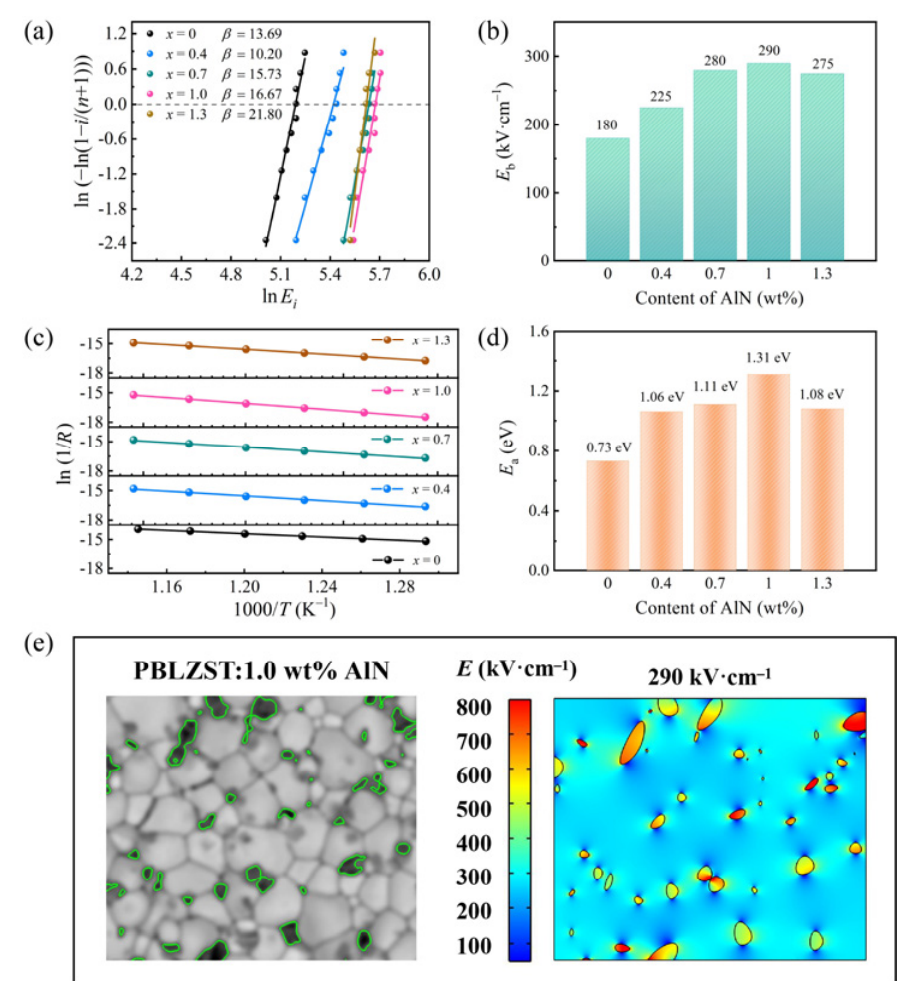
Fig. 5 (a) Weibull distribution of the E b for all samples, and the slope β is the Weibull modulus associated with the linear regressive fit of the distribution. (b) Dependence of E b on AlN contents. (c) ln(1/ R ) versus 1000/ T for the the PBLZST: x wt% AlN ceramics in the form of Arrhenius plots. (d) Relationship between the activation energy ( E a ) and the AlN content. (e) Electric field distribution in the PBLZST:1.0 wt% AlN composite ceramic at 290 kV·cm –1 simulated by the finite element